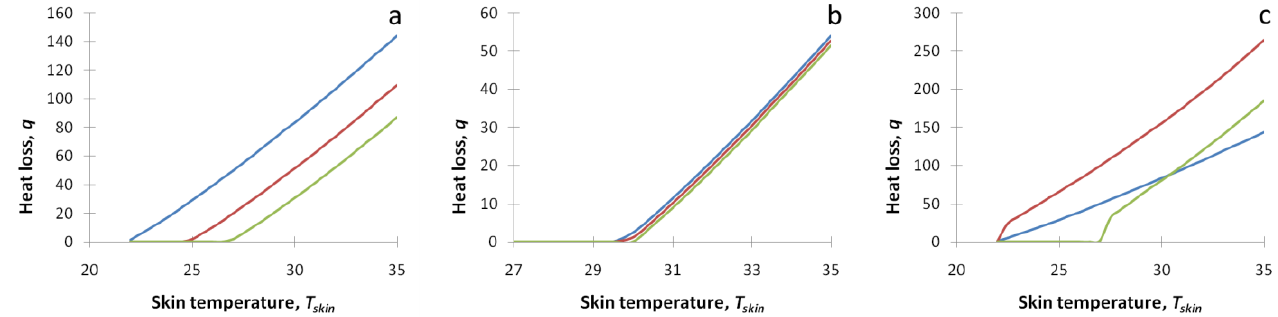
Figure 1. The dependence of the heat loss function, q [W/m 2 ], on the skin temperature T skin [°C]. ( panel a ): q ( T skin ) for various values of the ambient temperature T ∞ (22 °C — blue line, 25 °C — red line, 27 °C — green line), ( panel b ): q ( T skin ) for various values of the relative humidity, RH (40% — blue line, 70% — red line, 100% — green line), T ∞ = 30 °C. ( panel c ): q ( T skin ) for various values of the skin wetness, W . ( T ∞ = 22 °C, W = 0 — blue line, T ∞ = 22 °C, W = 1 — red line, T ∞ = 27 °C, W = 1 — green line). Skin emissivity ε was set to 0.98.